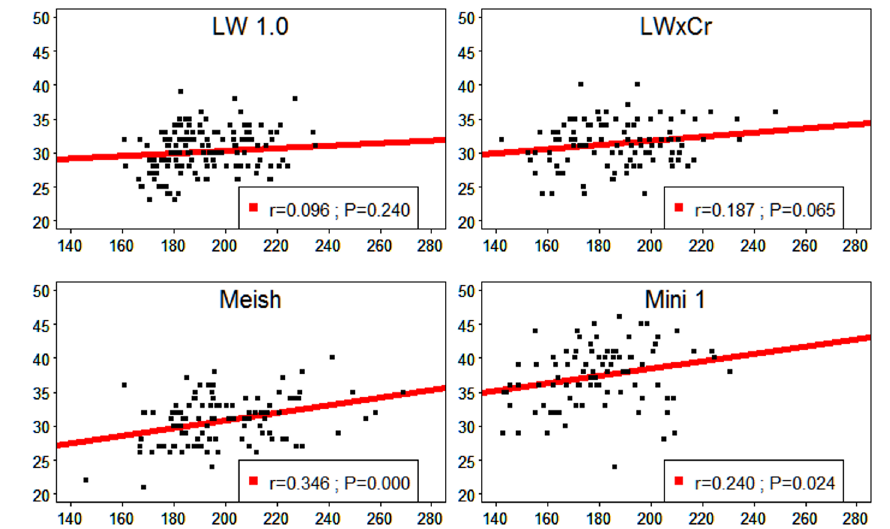
Figure 2. Relationship between the number of MLH1 foci and the total SC length for the four boars analyzed. x-axis: total length of autosomal SC per cell ( m m); y-axis: total number of MLH1 foci per cell.